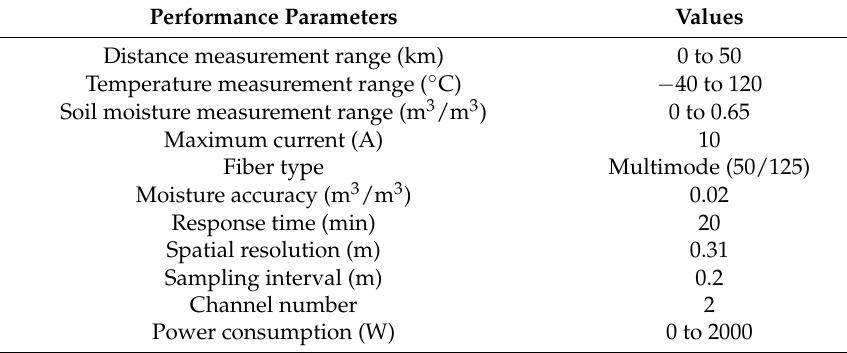
Table 1. Basic parameters of the distributed moisture sensing (DMS) interrogator (NZS–DMS–M02). Performance Parameters